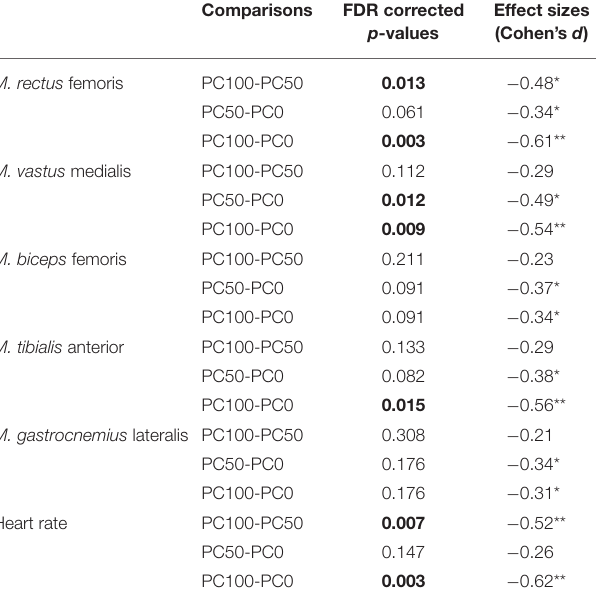
Comparisons FDR corrected Effect sizes p -values (Cohen’s d